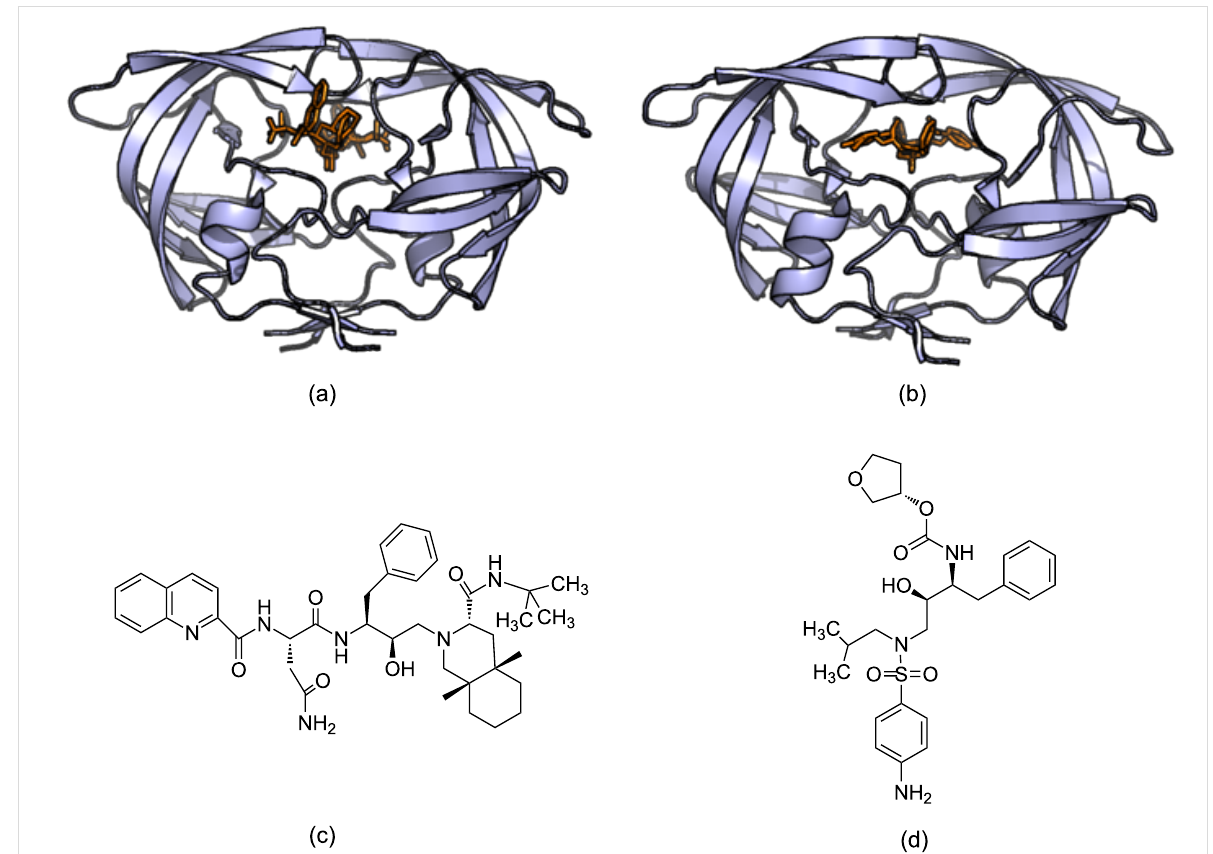
Figure 2: FDA approved drugs Saquinavir and Amprenavir for the treatment of HIV infections. (a) The structure of Saquinavir in complex with HIV-1 protease (3OXC) (b) the structure of Amprenavir in complex with HIV-1 protease (3NU3) (c) the molecular structure of Saquinavir and (d) the molecu- lar structure of Amprenavir. Amprenavir and Saquinavir target HIV-1 protease and, in part, have been discovered through structure-based computer aided drug discovery